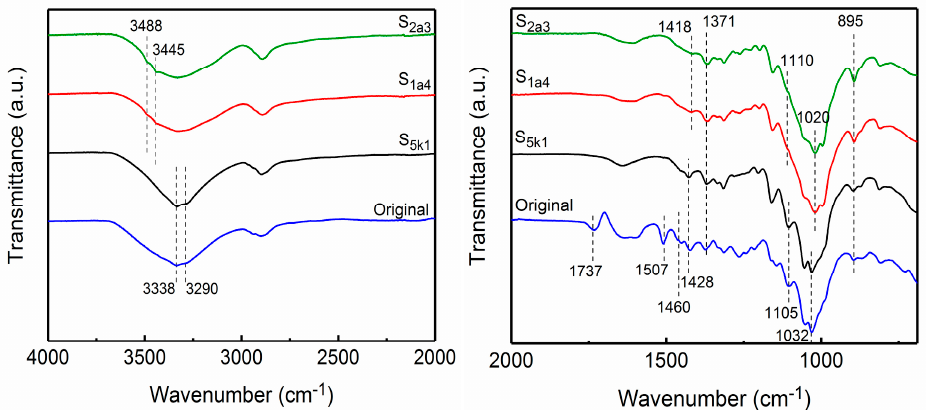
Figure 3. FTIR spectra of the samples: original wood, S 5k1 , S 1a4 , and S 2a3 .